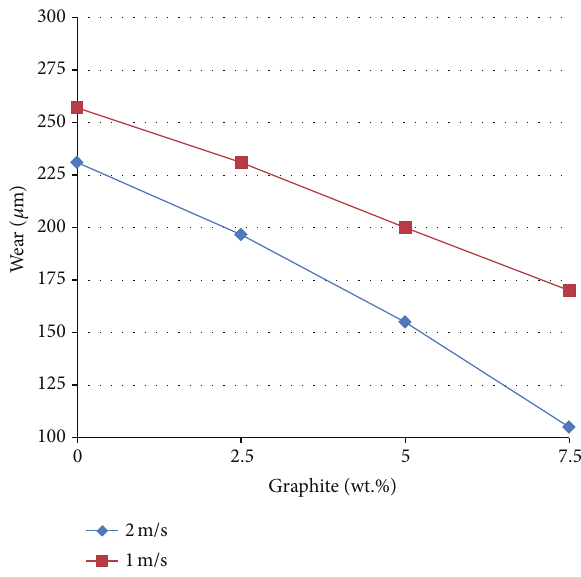
Figure 8: Variation of wear as a function of graphite content and sliding velocities of 1m/s and 2m/s at constant normal load of 49 N.